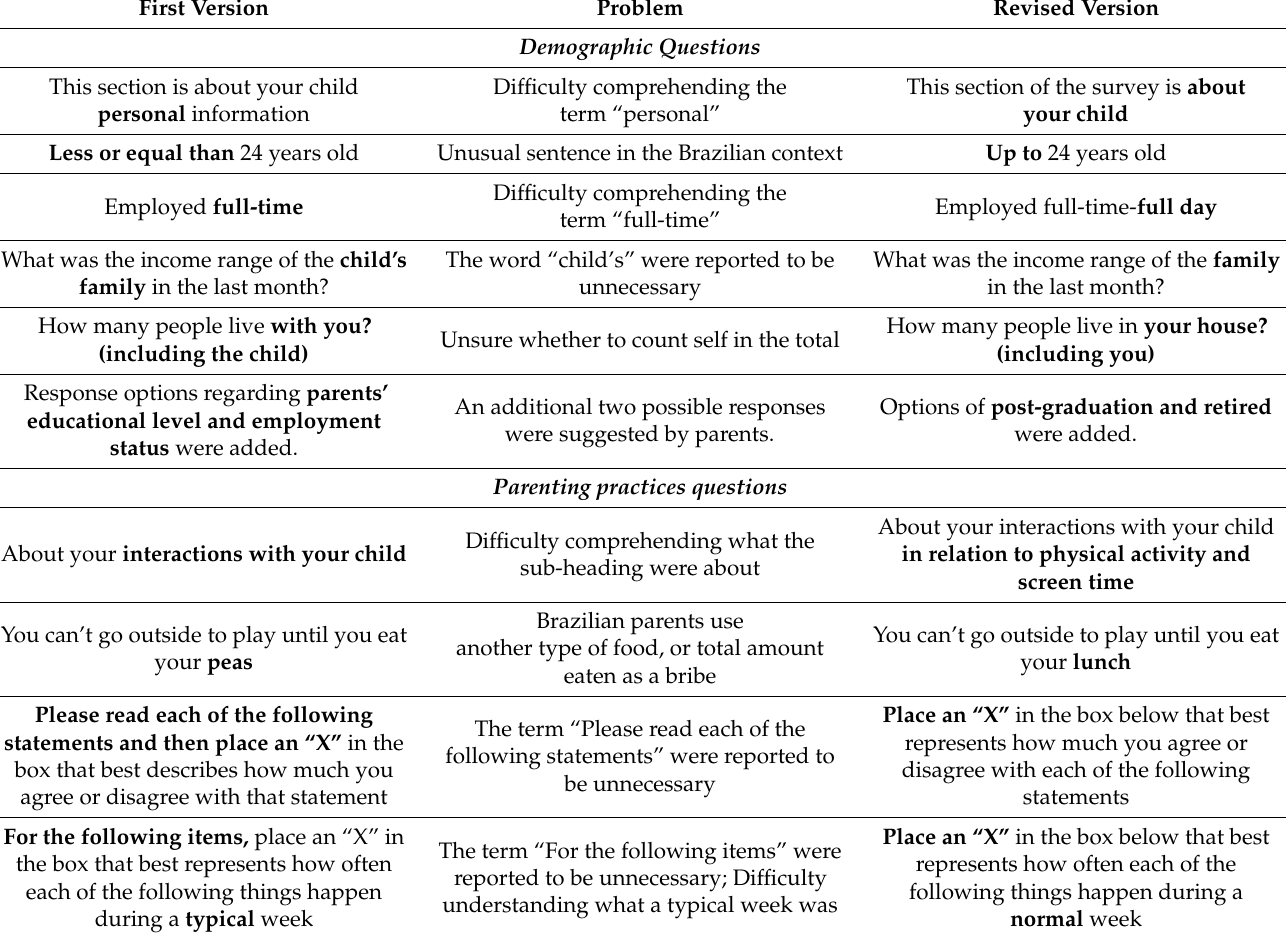
Table 4. Problems and solutions that were identified in cognitive